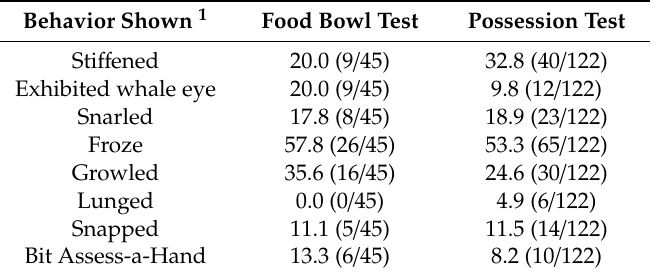
Table 1. The percentages of resource guarding dogs that displayed specific behaviors during the food bowl test and possession test. The number of dogs that displayed the behavior / number of dogs assessed as resource guarding on the particular test are in